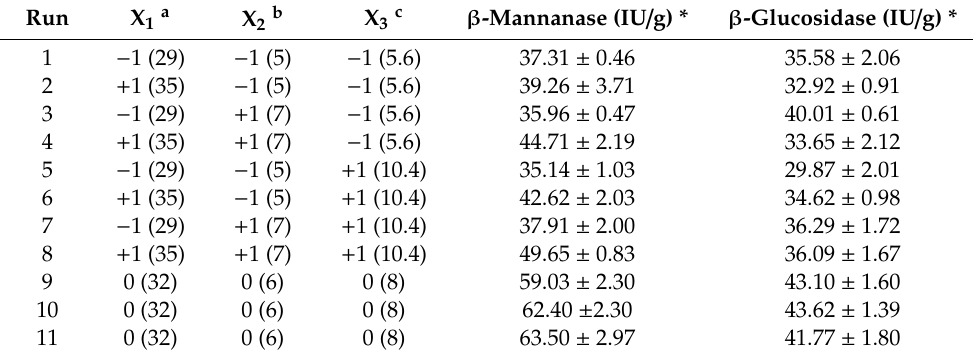
Table 3. Factorial 2 3 design for the production of enzymes (IU / g) in 72 h of SSF with A. niger F12 and 1:1 ( w / w ) co ff ee waste:wheat bran under di ff erent conditions of temperature, pH and initial moisture content.